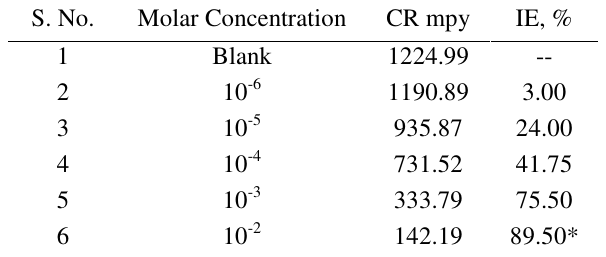
Table 2 . Dependence of concentration of AMCl on the corrosion inhibition of MS in 1M H SO ( 5 hours study). 2 4